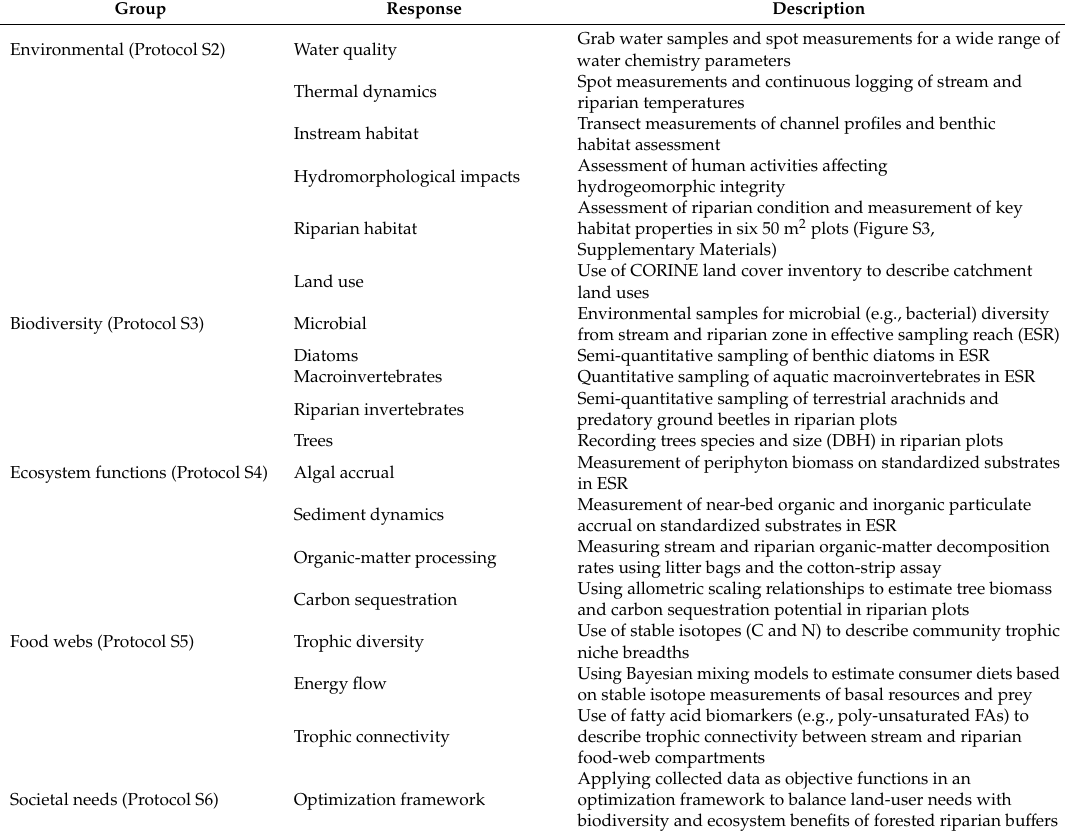
Table 2. Overview of ecosystem attributes and approaches used in the CROSSLINK project to describe the multiple ecological benefits of forested riparian bu ff ers in human-impacted